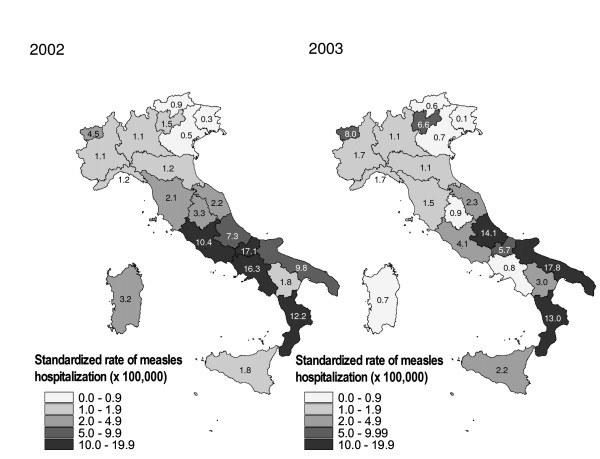
Standardised rate of measles hospitalizations per 100,000 inhabitants, by region. Italy 2002 and 2003.